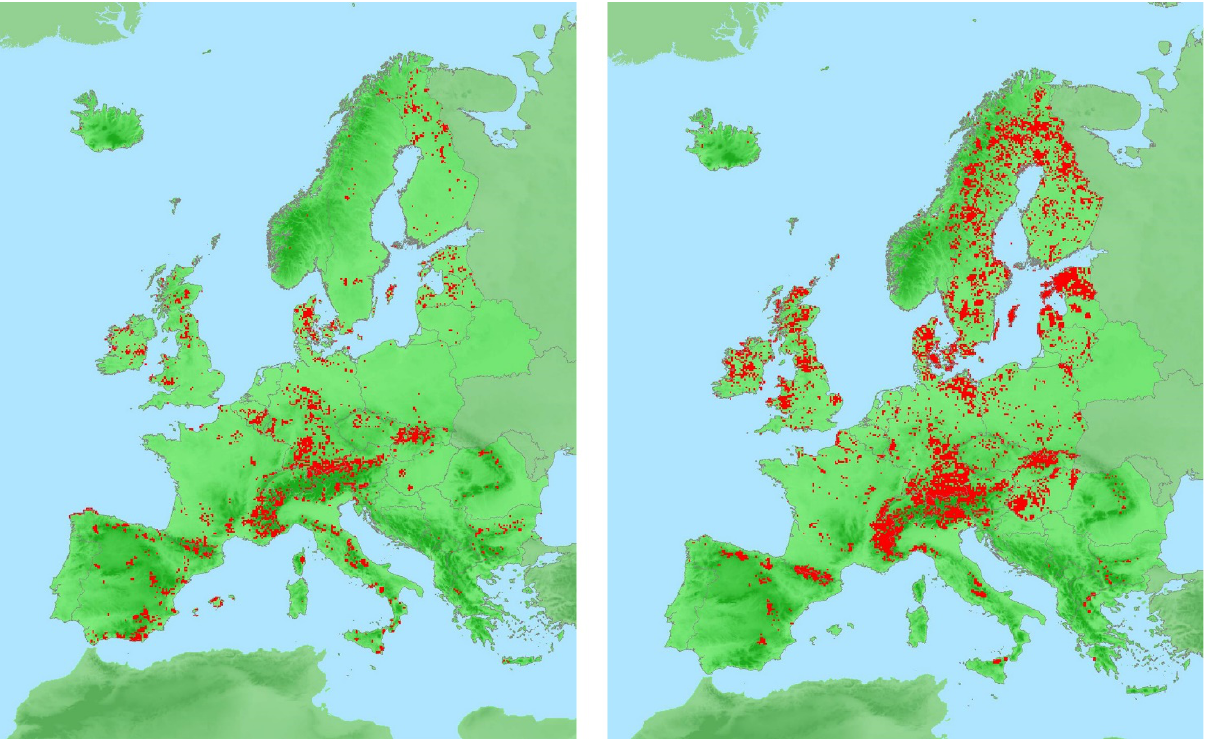
Figure 1. Occurrence across Europe of (left) Petrifying-springs, associated tufa cascades, small streams and flushes; and (right) of Alkaline-fens and Calcareous-spring-mires. Data originate from Toivonen 2016 (left) and Bita-Nicolae et al . 2016 (right). Information on Norway, Iceland, Portugal and former Yugoslavian countries may be